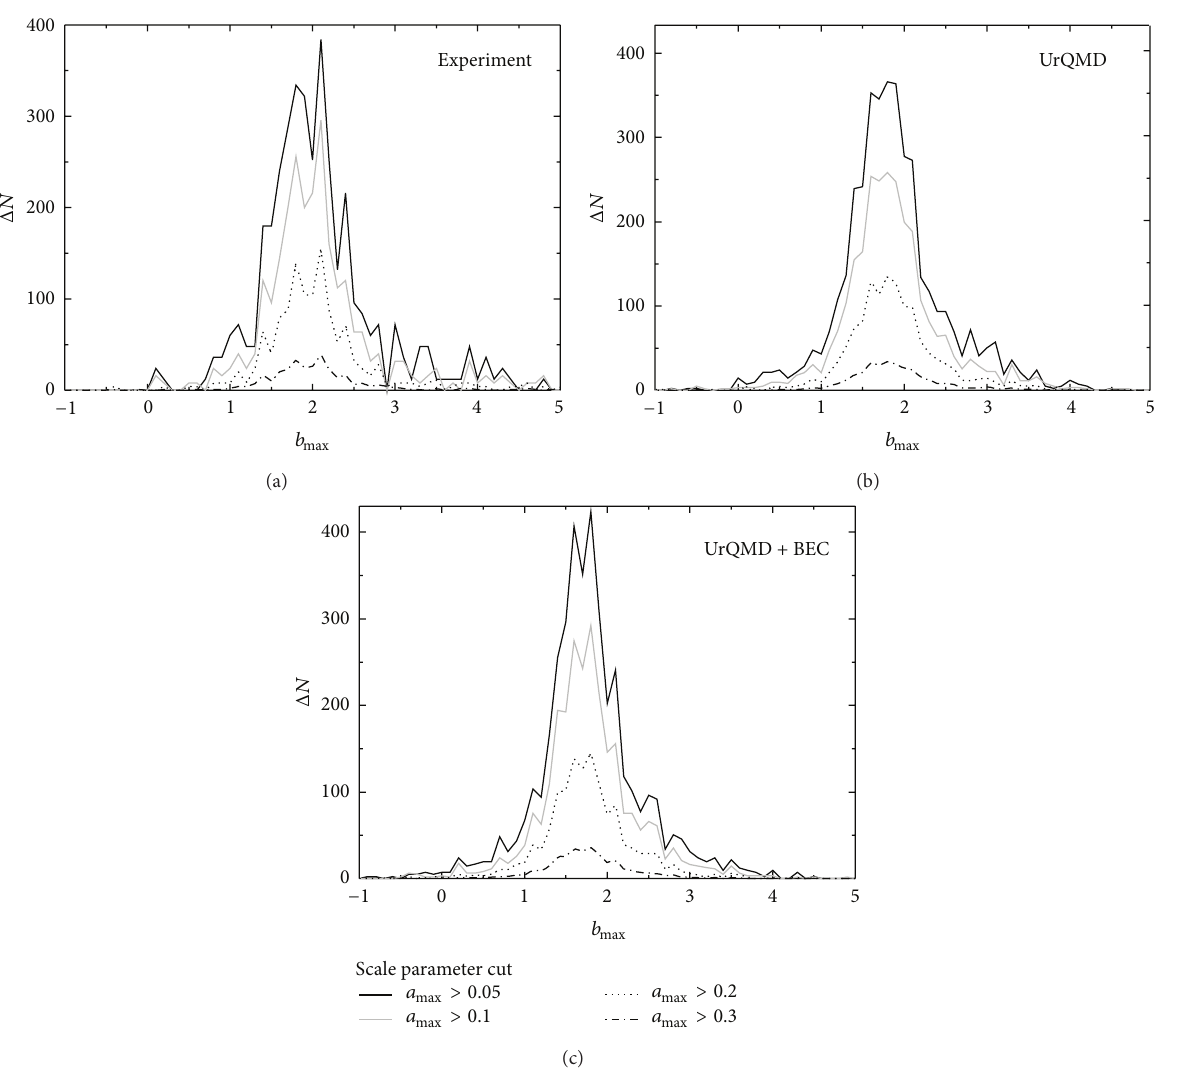
Figure 8: 𝑏 max distributions for different scale windows in 28 Si-Ag/Br interaction at 14.5AGeV—(a) the experiment, (b) the UrQMD, and (c) the UrQMD + BEC. The distributions in different scale windows are so shifted as to avoid mutual